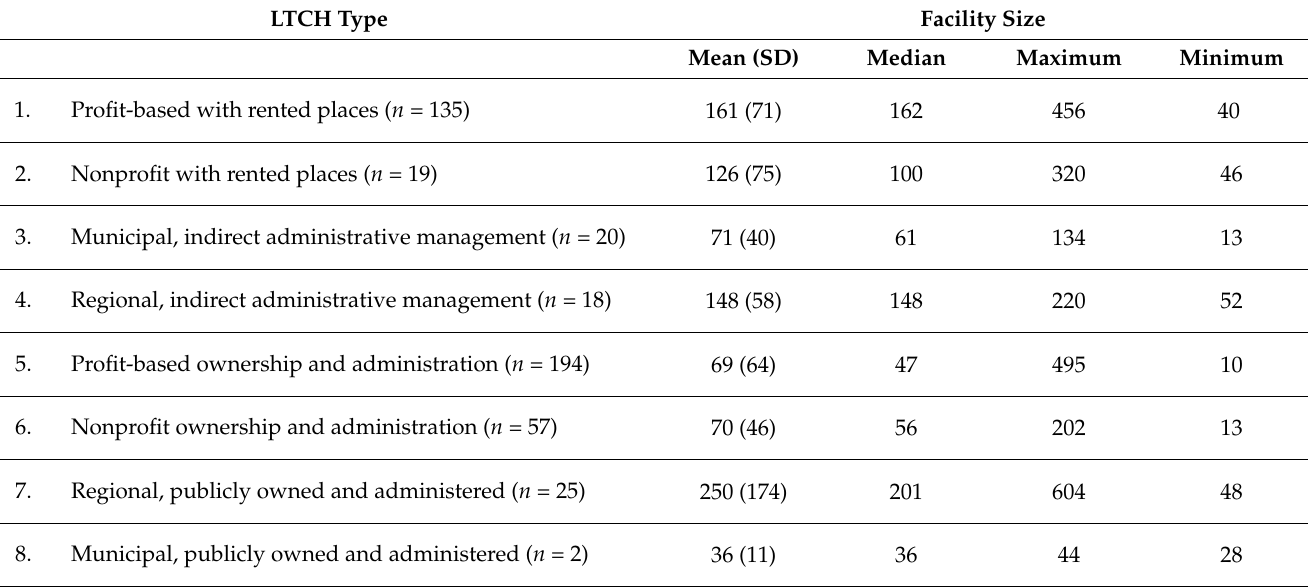
Table 2. Descriptive statistics of LTCH size by LTCH type in the Community of